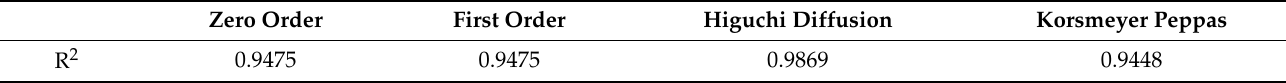
Table 3. Release kinetics for optimized formulation F10.